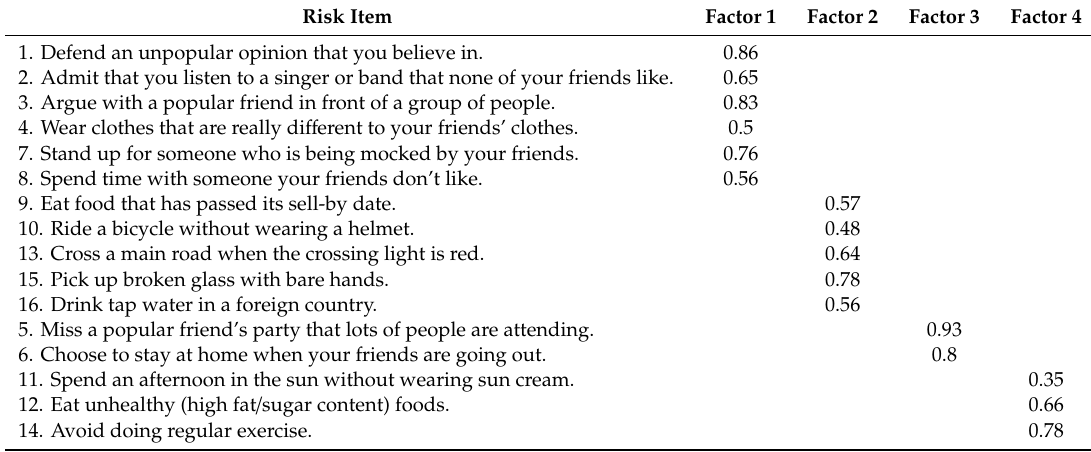
Table 1. Item loadings from the exploratory factor analysis